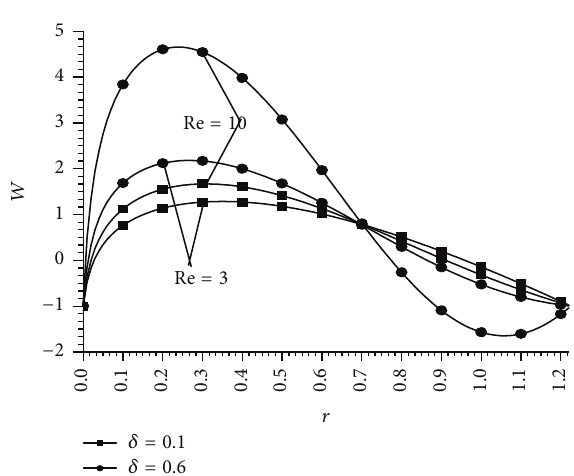
Figure 2: The velocity distribution 𝑤 , across the annulus with different values of Re and 𝛿 at 𝜖 = 0.01 , Wi = 0.01 , 𝑄 = 1.5 , 𝜙 = 0.4 , and 𝑧 = 0.1 , where 𝑟 ∈ [𝜖, 𝑟 2 ] .